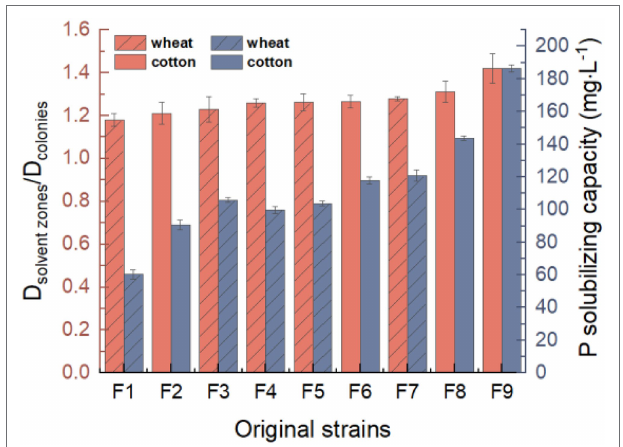
FIGURE 1 | Screening of phosphate solubilizing fungi from rhizospheric of crops. The red represents D solvent zones / D colonies value, and the blue represents P-solubilizing